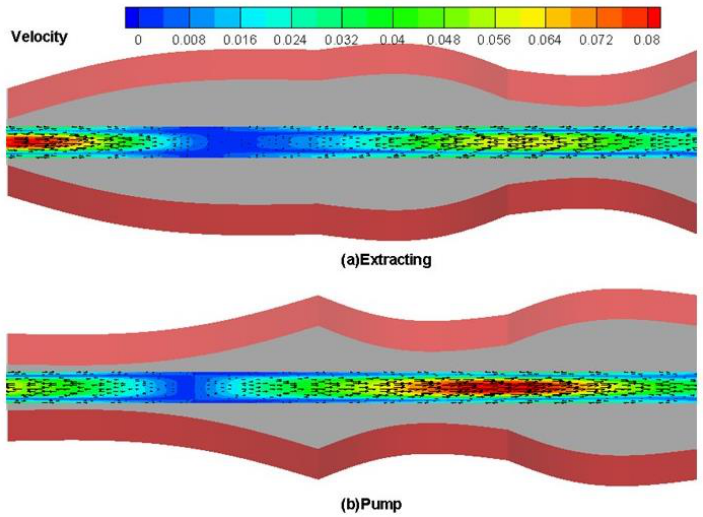
Figure 3. Fluid pumping through the device—instantaneous velocity vector contours at 50 Hz. ( a ) Extracting; ( b ) pumping.